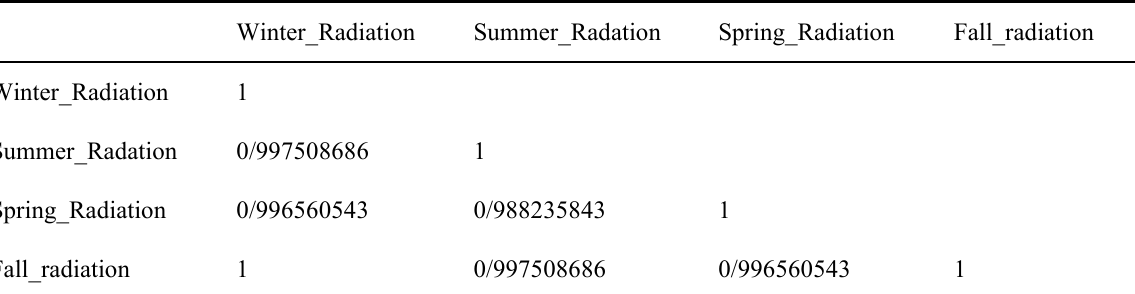
Table 3. Correlation among amounts of radiation in different seasons